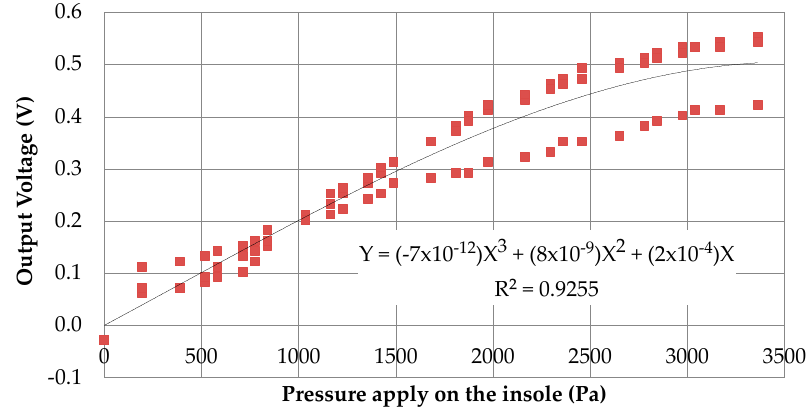
Figure 5. Output voltage of Hall effect sensor with a one millimeter magnet.